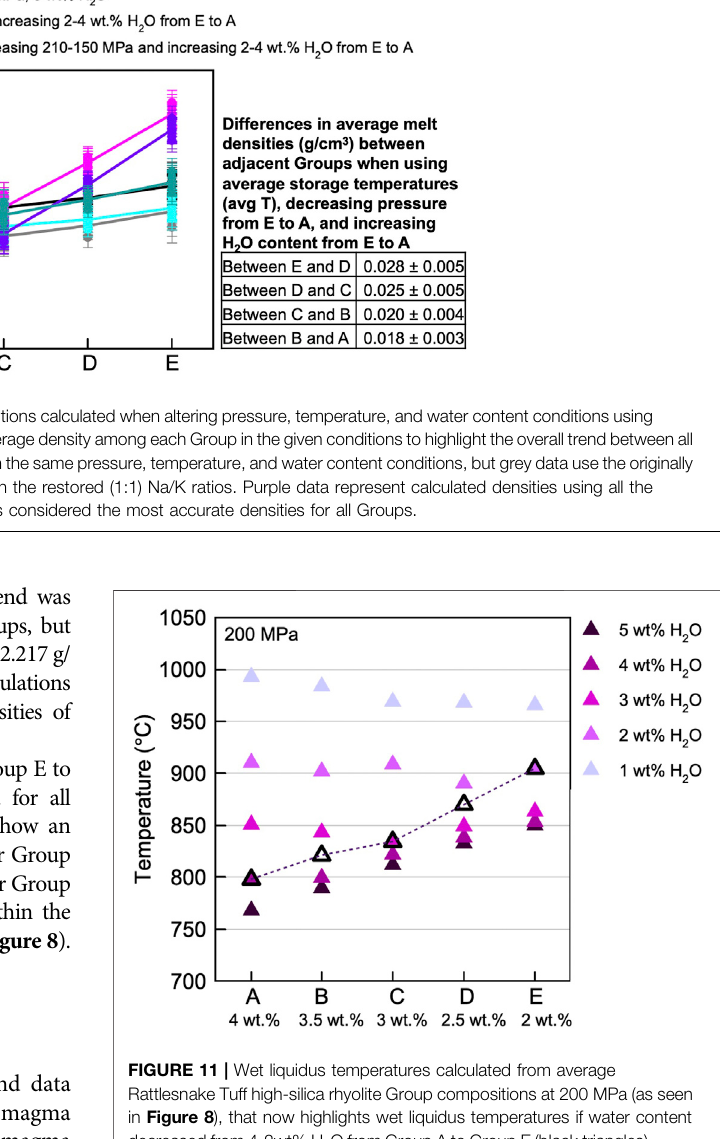
along a crystallizing roof mush zone.